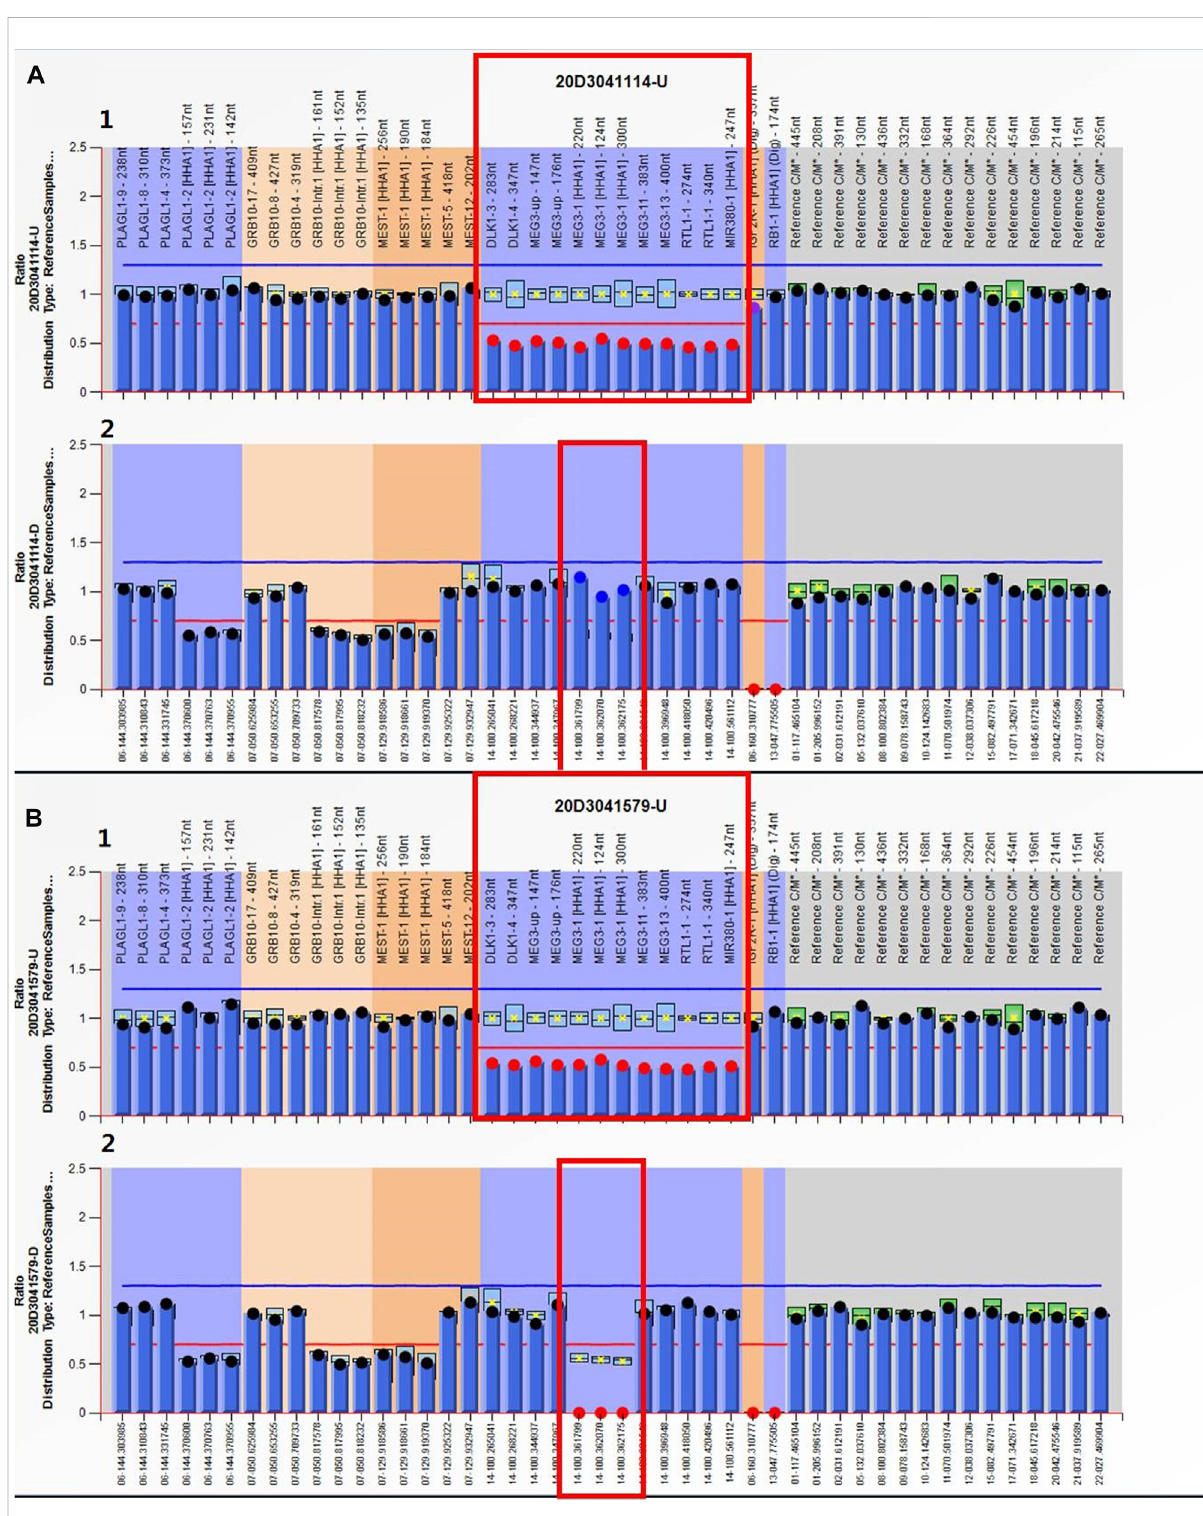
FIGURE 4 MS-MLPA results. Electropherograms and normalized data for the (A) proband and (B) the mother. (A1, B1) Copy number ratio of the 14q32 region was ~0.5 for both cases (before HhaI digestion) (red box). Three of these probes contain a HhaI recognition site that can provide information about MEG3 ’ s methylation status. (A2, B2) Methylation ratio of the MEG3 of chromosome 14q32 after digestion was ~1 for the proband and ~0 for its mother (red